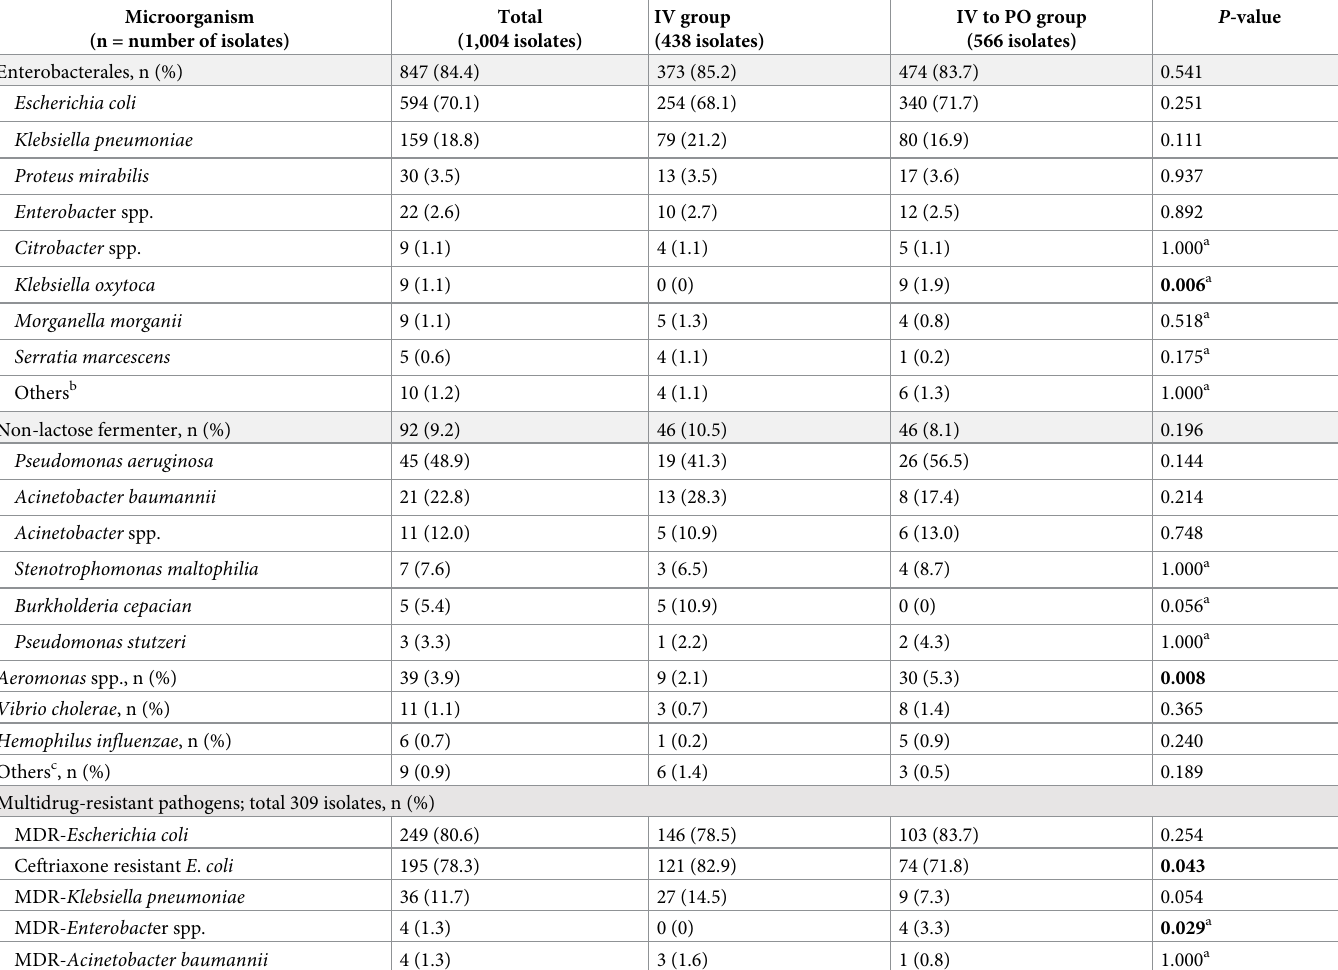
Table 2. Microorganisms of hospitalized patients with Gram-negative bloodstream infection continuing intravenous antibiotic agents or receiving intravenous to oral transition antibiotics (n = 1,004 isolates). Microorganism (n = number of isolates)